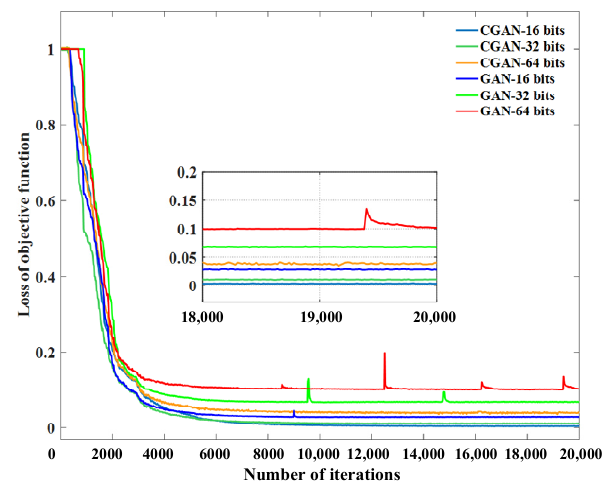
Figure 10. The result of the objective-function loss.